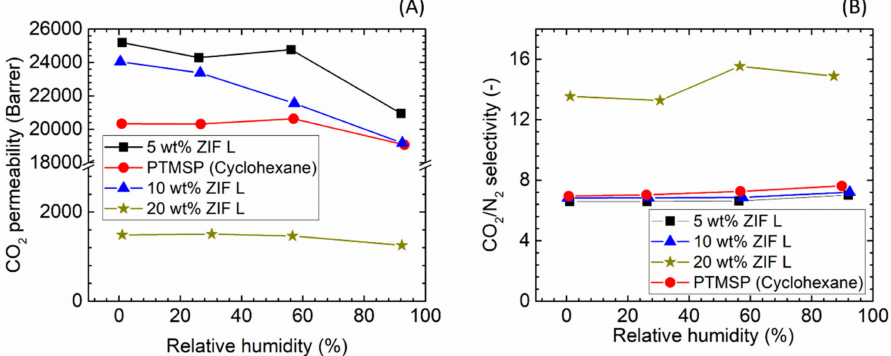
Figure 12. Gas separation performances of PTMSP/ZIF-L hybrid membranes as a function of relative humidity in the gaseous stream. ( A ) CO 2 permeability and ( B ) CO 2 /N 2